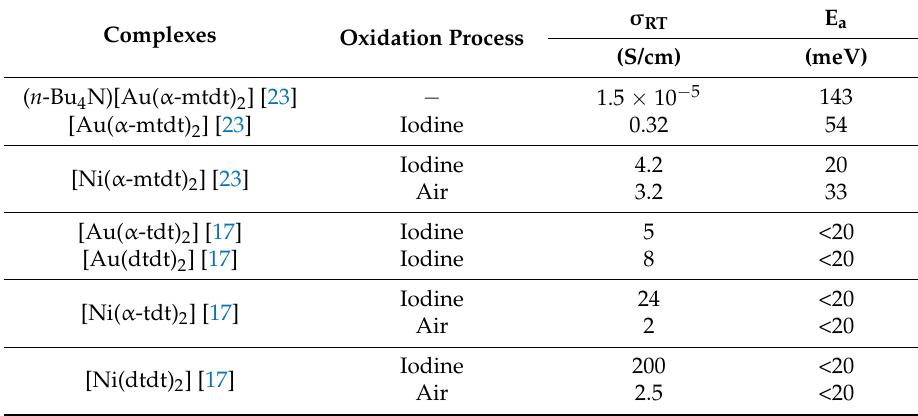
Figure 8. Electrical resistivity π ( a ) and absolute thermoelectric power S ( b ) of the neutral complexes [M( α -mtdt) 2 ] ◦ (M = Au and Ni) as a function of absolute temperature T . Table 1. Room-temperature electrical conductivity ( σ RT ) and activation energy (E a ) for [M( α -mtdt) 2 ] (M = Au and Ni) and related